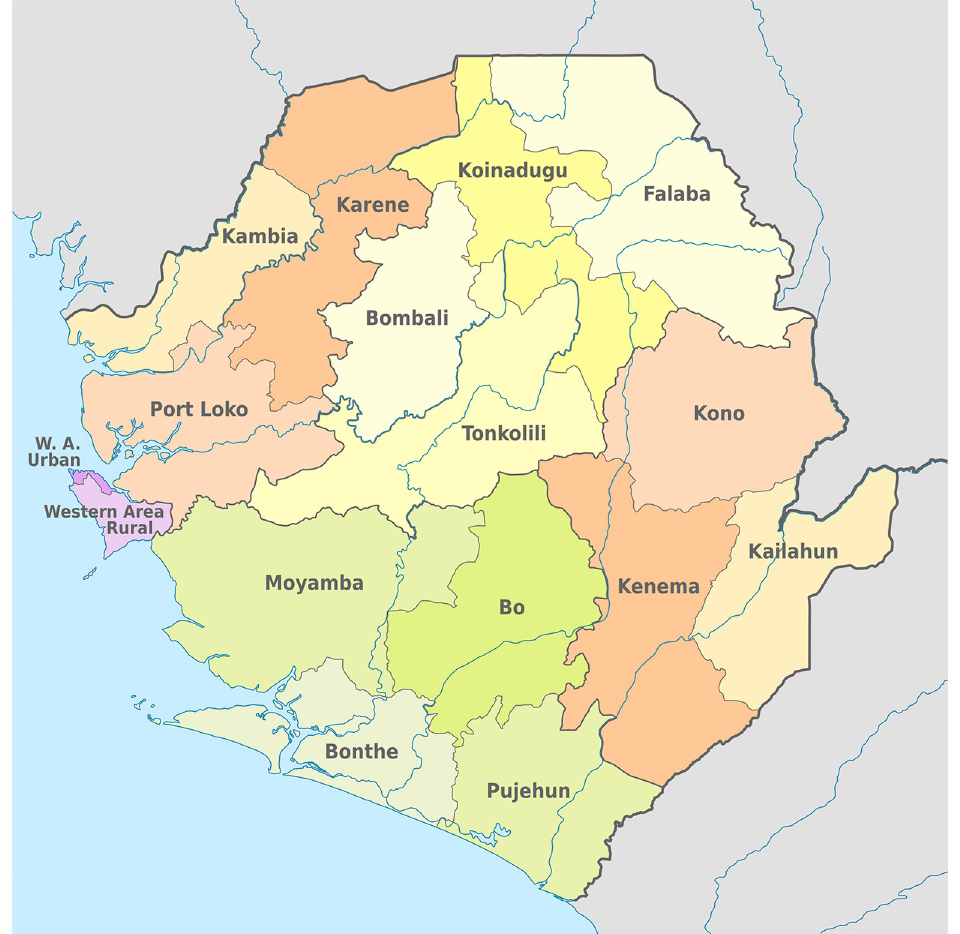
Fig 1. Map of Sierra Leone with District Boundaries. Map of Sierra Leone showing District and Chiefdom Borders. Map source: https://commons.wikimedia.org/wiki/File:Districts_in_Sierra_Leone_2018.svg.